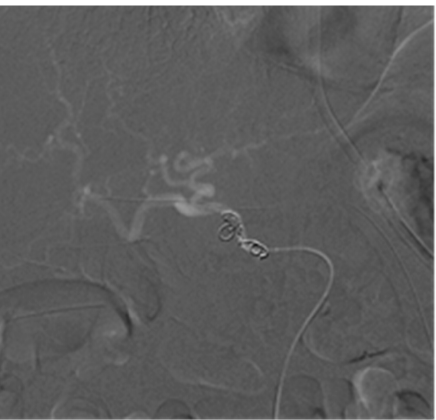
Figure 5. Angiography showing the preserved blood flow of the common and proper hepatic artery and distal branches after embolization with coils, but the GDA stump did not become filled with contrast